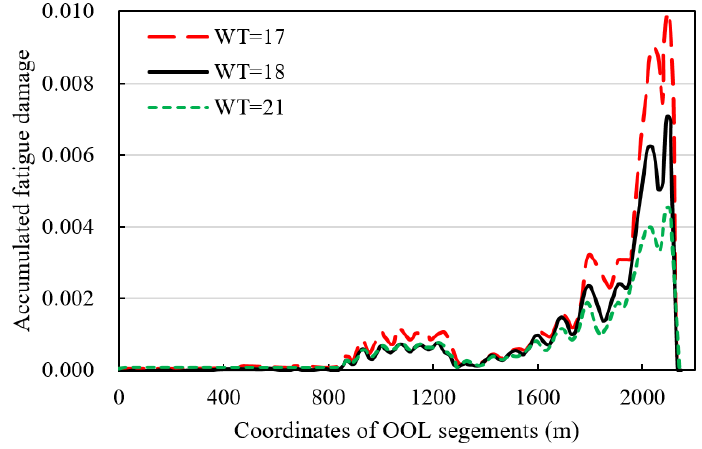
Figure 17. Fatigue damage of OOL with different wall thickness.